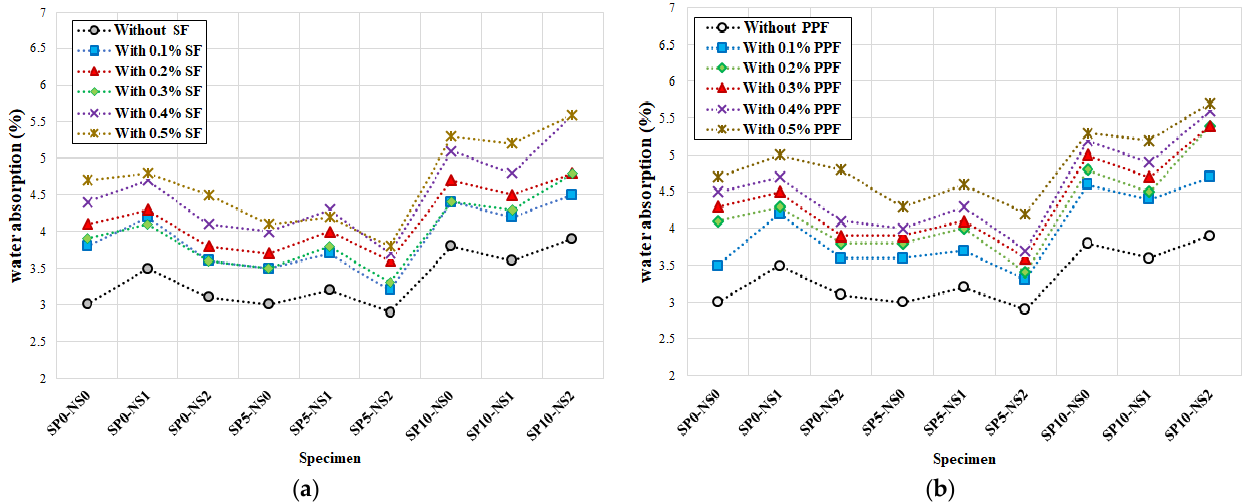
Figure 18. Impact of the fibres on the water absorption of HSC containing NS and SP ( a ) SF and ( b ) PPF.